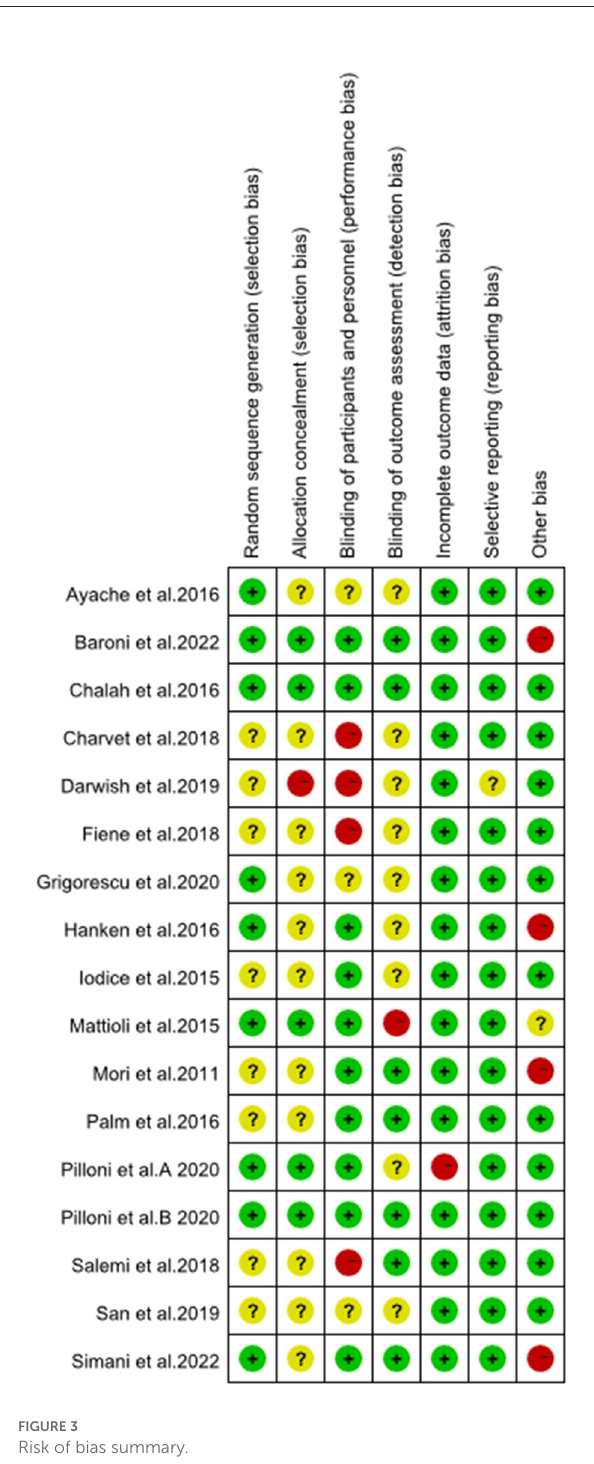
function, mean age ( P = 0.525) and EDSS ( P = 0.726) did